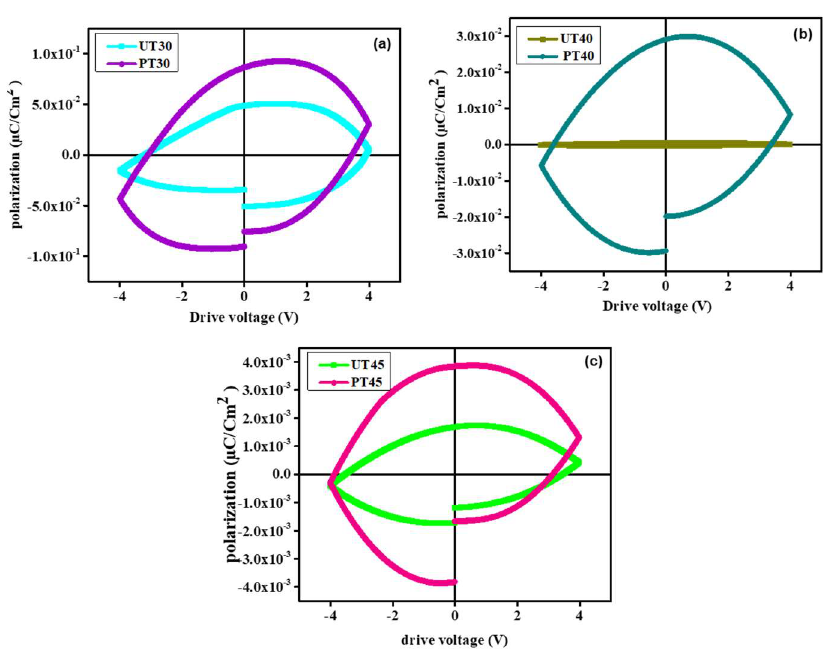
Figure 7. Polarization − electric field profiles of UT30, PT30 ( a ) UT40, PT40 ( b ), and UT45, PT45 ( c